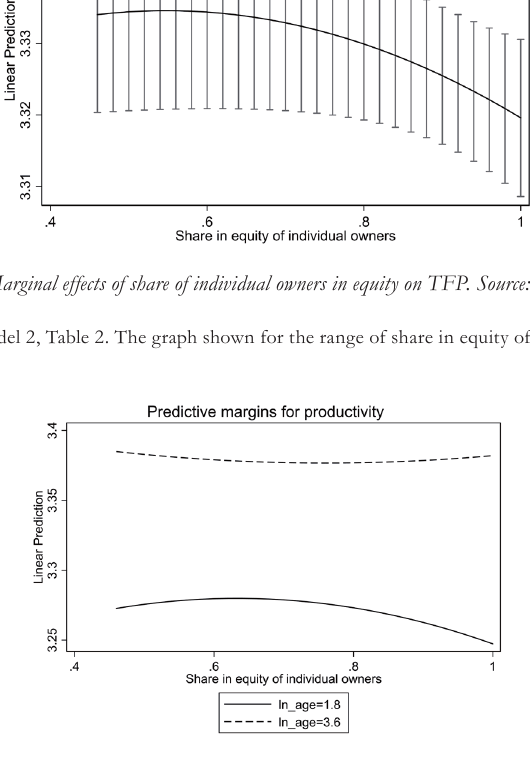
Fig. 3 – The marginal effect of share of individual owners in equity on TFP conditioned on firm’s age. Source: own